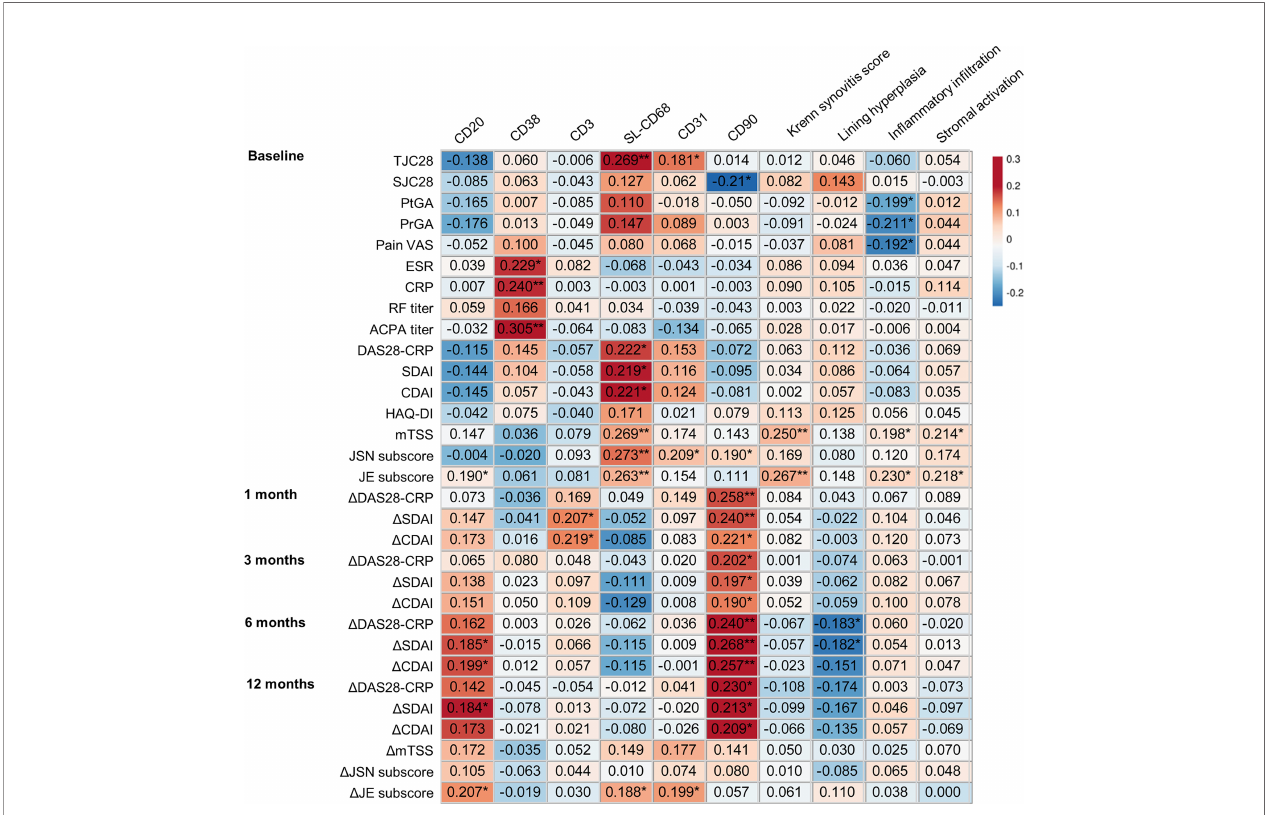
FIGURE 2 | Relationship of baseline synovitis assessments with clinical characteristics of RA patients during 1-year follow up. D DAS28-CRP(1/3/6/12)/ D SDAI(1/3/6/ 12)/ D CDAI(1/3/6/12), changes in DAS28-CRP/SDAI/CDAI from baseline to 1/3/6/12 months; D mTSS(12)/ D JSN(12)/ D JE(12), changes in mTSS/JSN subscore/JE subscore from baseline to 12 months. * p < 0.05; ** p <